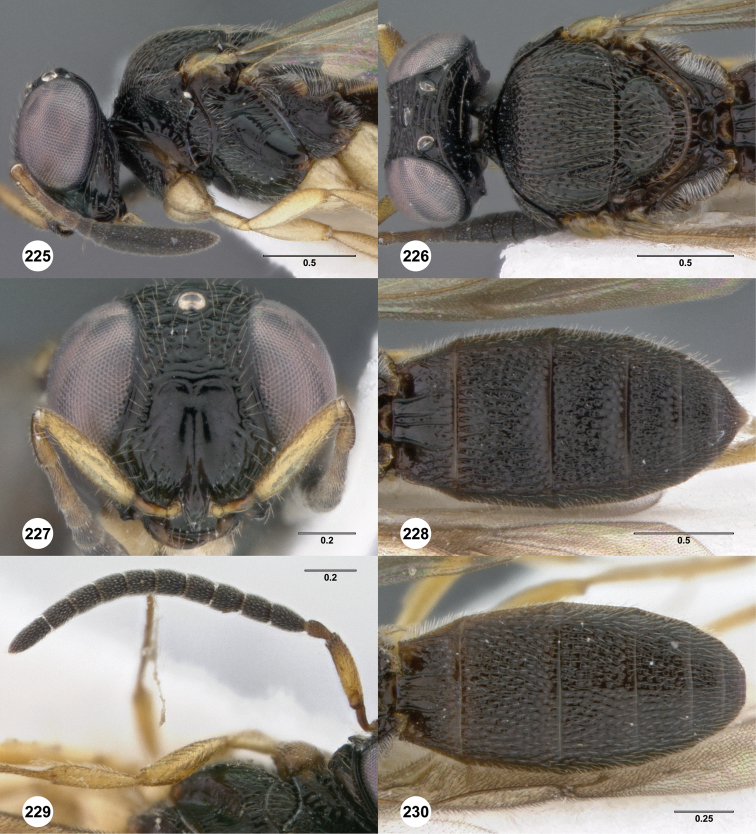
Oxyscelio obliquiatis sp. n., holotype female (OSUC 359747) 225 Head and mesosoma, lateral view 226 Head and mesosoma, dorsal view 227 Head, anterior view 228 Metasoma, dorsal view. Paratype male (OSUC 359780) 229 Antenna 230 Metasoma, dorsal view. Morphbank71